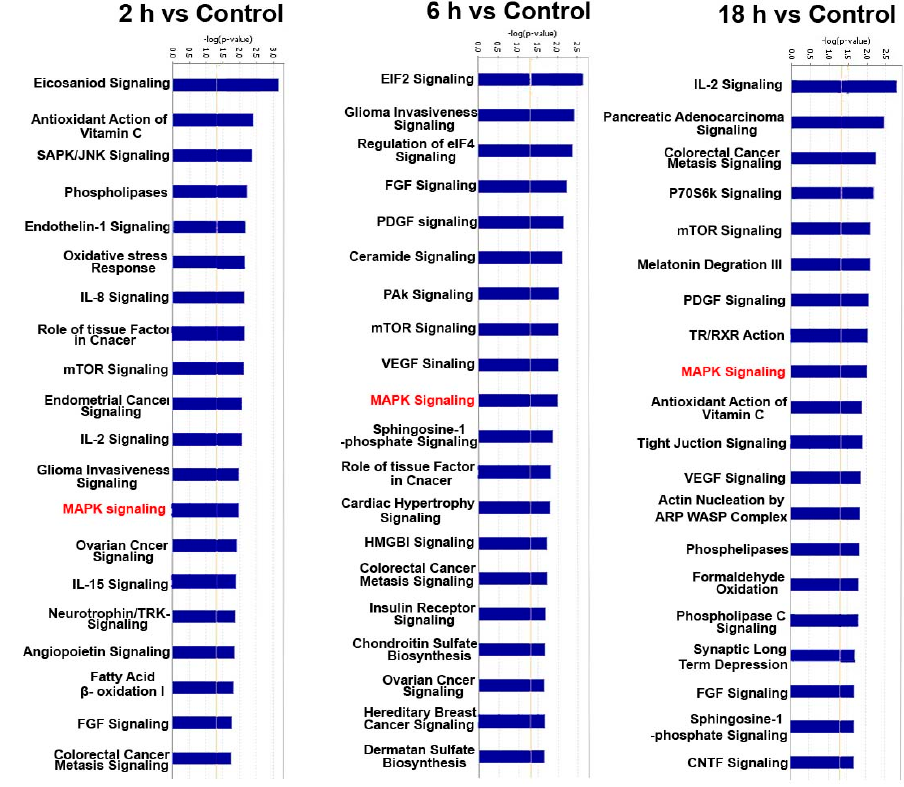
Figure 6. The cell pathways of these 66 differentially expressed miRNAs ( p < 0.05) as analyzed by IPA.